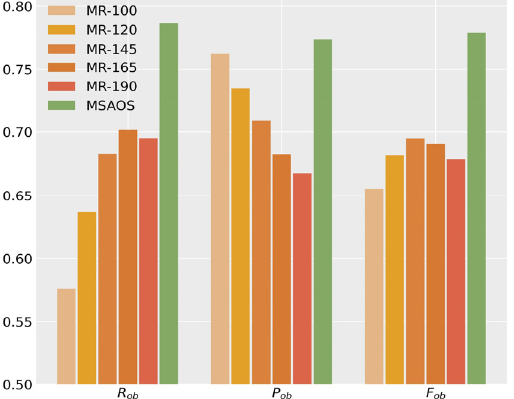
Figure 10. The average R ob , P ob , and F ob values obtained for the eight test tiles using the MSAOS and MR segmentation algorithms with five segmentation scales: 100, 120, 145, 165 and 190.